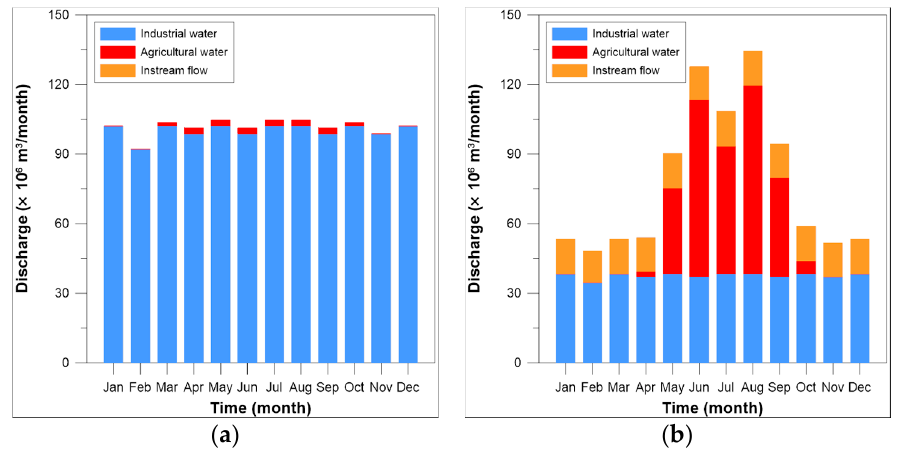
Figure 5. Monthly water supply planning of two dams: ( a ) Soyanggang dam; ( b ) Andong dam. Table 2. Project data of two dams.